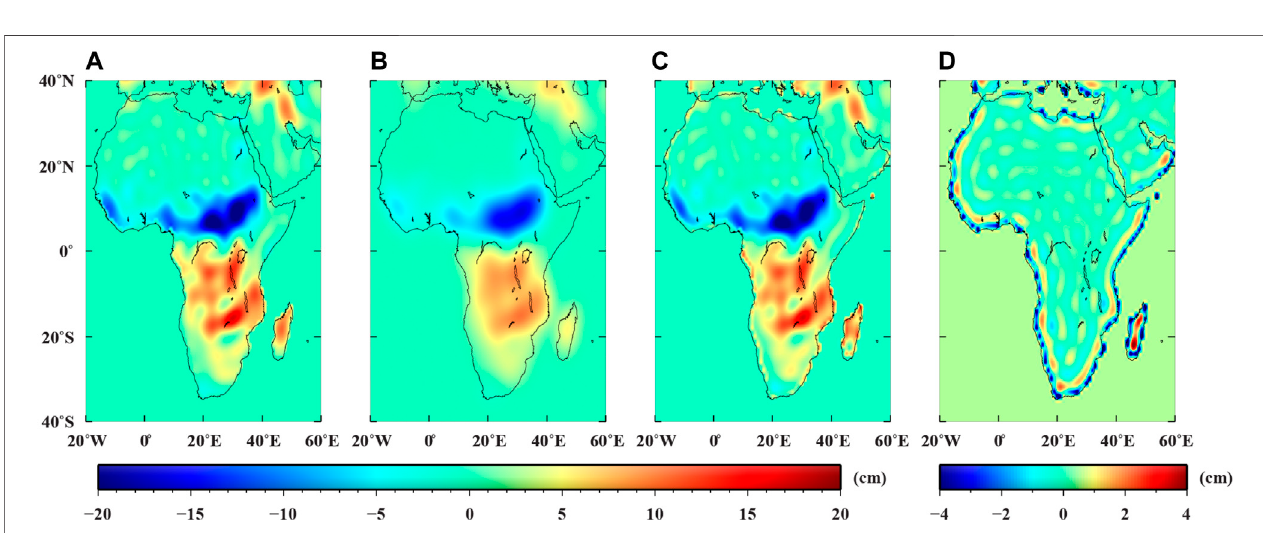
FIGURE3| Degreevariancesofgeoidheightfordifferentsolutionsfor5 years.Redlines:ESMHISsignal;Greenlines:SHCsestimated bysimulatedGRACEdata; Blue lines: SHCs estimated by simulated GRACE Follow-On data.